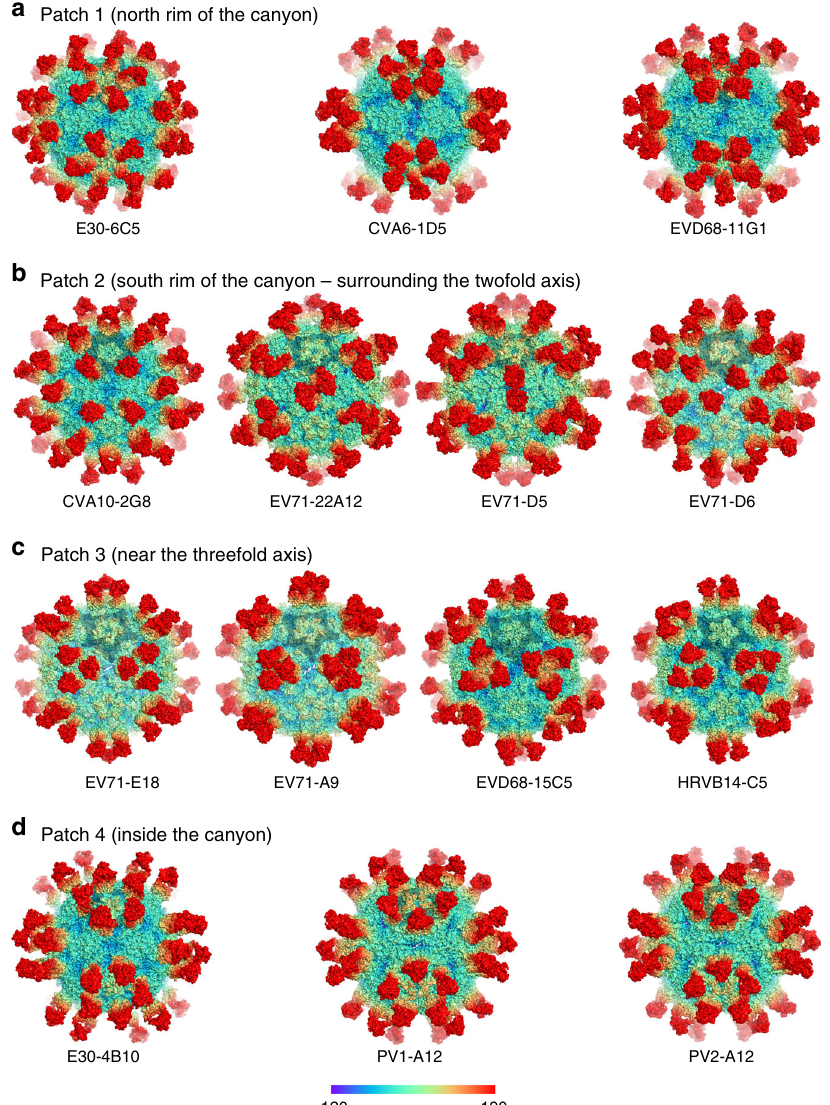
Fig. 6 Classi fi cation of the enterovirus-Fab-complexes. All published complexes of enterovirus and neutralizing MAb were utilized for comparison. The complexes can be classi fi ed into four patches, a patch 1 — around the north rim of the canyon, including E30-6C5, CVA6-1D5 (PDB CODE: 5XS7) and EVD68-11G1 (PDB CODE: 6AJ9), b patch 2 — around the south rim of the canyon, which includes EV71-D6 (PDB CODE: 5ZUD), CVA10-2G8 (PDB CODE: 6AD0), EV71-22A12 (PDB CODE: 3J91) and EV71-D5 (PDB CODE: 3JAU), c patch 3 — near the threefold axis constituted by EV71-E18 (PDB CODE: 4C0U), EV71-A9 (PDB CODE: 5ZUF), EVD68-15C5 (PDB CODE: 6AJ7) and HRVB14-C5 (PDB CODE: 5W3E), and d patch 4 — inside the canyon, including E30- 4B10, PV1-A12 (EMDB CODE: 5670) and PV2-A12 (EMDB CODE: